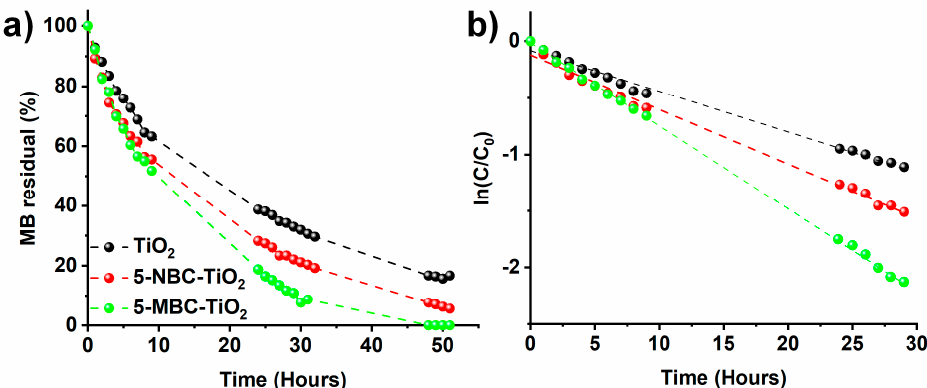
Figure 9. ( a ) Fifty-one-hour degradation tests performed on TiO 2 (black), 5-NBC-TiO 2 (red), and 5-MBC-TiO 2 (green). ( b ) Linearization by fitting with a first order kinetic model.